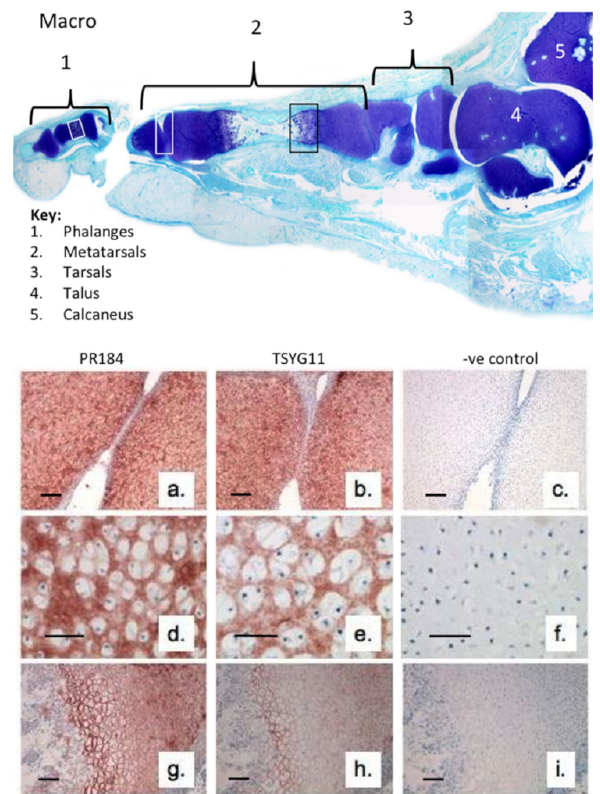
Figure 1. Macroscopic vertical section through a 14-week gestational age human fetal foot stained with toluidine blue-fast green (macroscopic views) to depict the cartilage rudiments and the areas used for immunolocalization ( a – i ). Immunolocalization of fibromodulin (FMOD) (pAb PR-184), scale bar = 100 µ m ( a , d , g ) and MMP-13-cleaved FMOD (pAb TsYG11) ( b , e , h ) in human fetal (14-week gestational age) metatarsal and phalangeal rudiment cartilage ( a , b ; d , e ) and metatarsal growth plates ( g , h ). Negative control sections are also depicted for the same cartilage areas ( c , f , i ). The immunolocalizations are representative of six sections from each sample zone taken from three feet